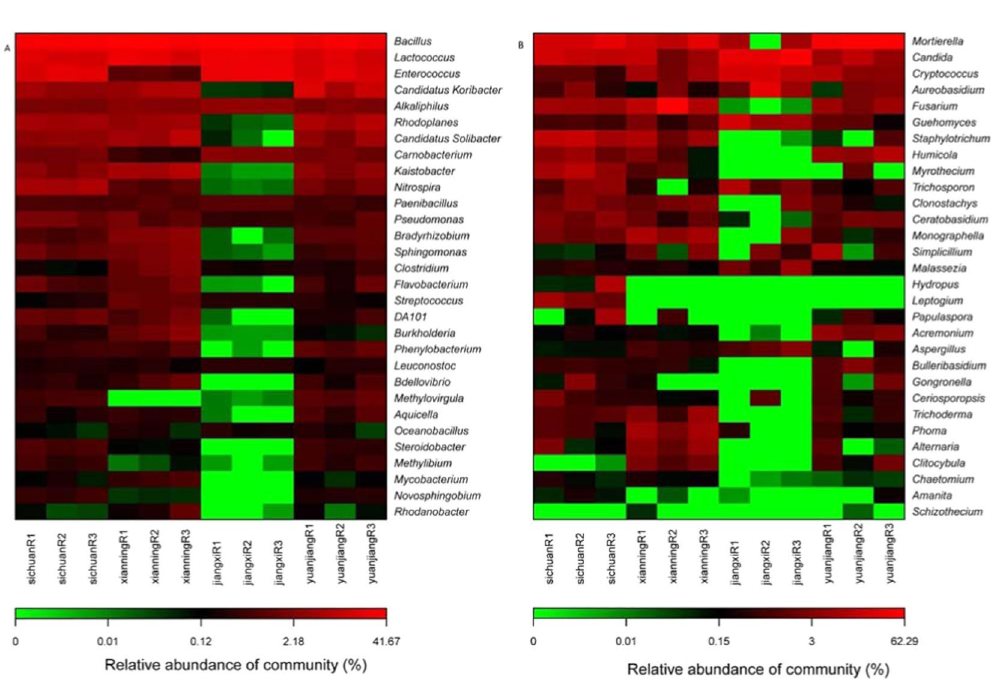
Figure 3. Heatmap analysis of bacterial ( A ) and fungi ( B ) based on the relative abundances of dominant genera from different areas continuous-cropping soil samples.